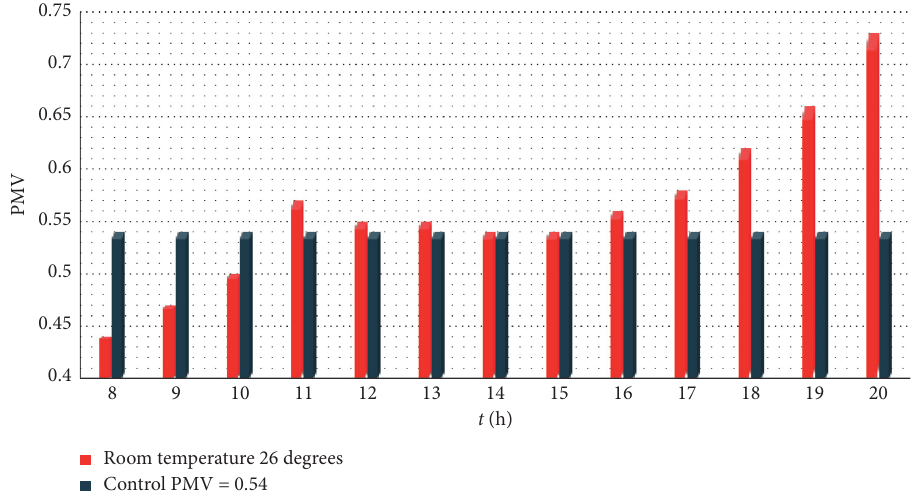
Figure 5: PMV variation under different control modes.